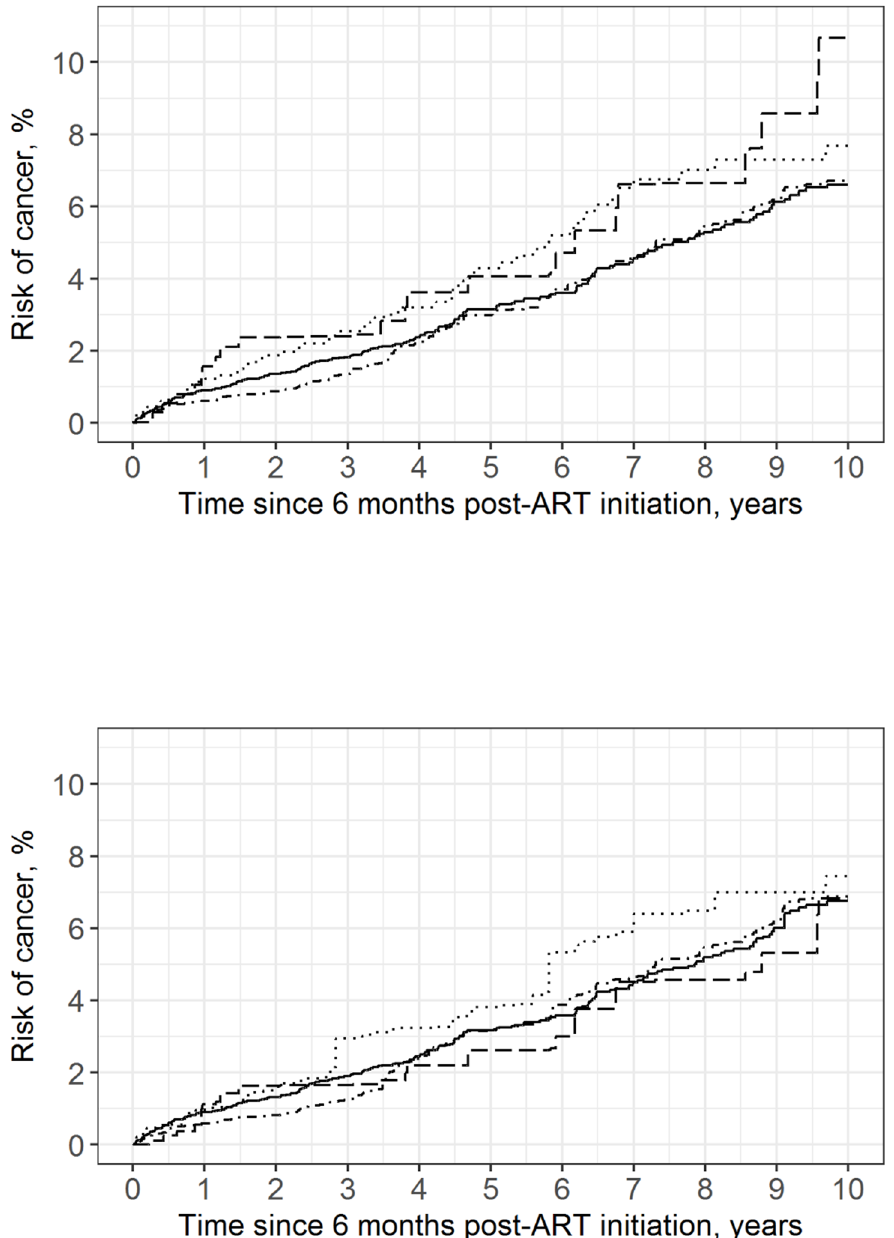
Fig 1. Crude and standardized risk curves for first cancer diagnosis in 7,515 CNICS patients, stratified by viral load category, averaged over 100 imputations. Standardized estimates controlled for age, sex, race/ethnicity, male-to-male sexual contact, injection drug use, smoking, at-risk alcohol use, pre-ART viral load, year of ART initiation, ART regimen, CD4 count, clinical AIDS status, chronic hepatitis status, statin use, and study site. Solid line represents viral loads < 20 copies/mL, dot-dashed line represents viral loads between 20 and 199 copies/mL, dashed line represents viral loads between 200 and 999 copies/mL, dotted line represents viral loads > 999 copies/mL. (a) Crude; (b) Standardized.